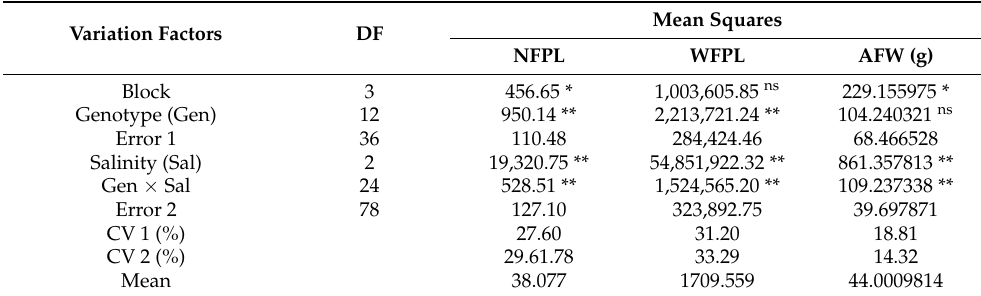
Table 5. Summary of analysis of variance of number of fruits per plant (NFPL), weight of fruits per plant (WFPL) (g plant − 1 ), and average fruit weight (AFW) (g fruit − 1 ) of combinations of ‘Tahiti’ acid lime ( Citrus × latifolia (Yu. Tanaka) Tanaka) with 13 rootstocks under water salinity, at 720 days after the onset of saline water irrigation.